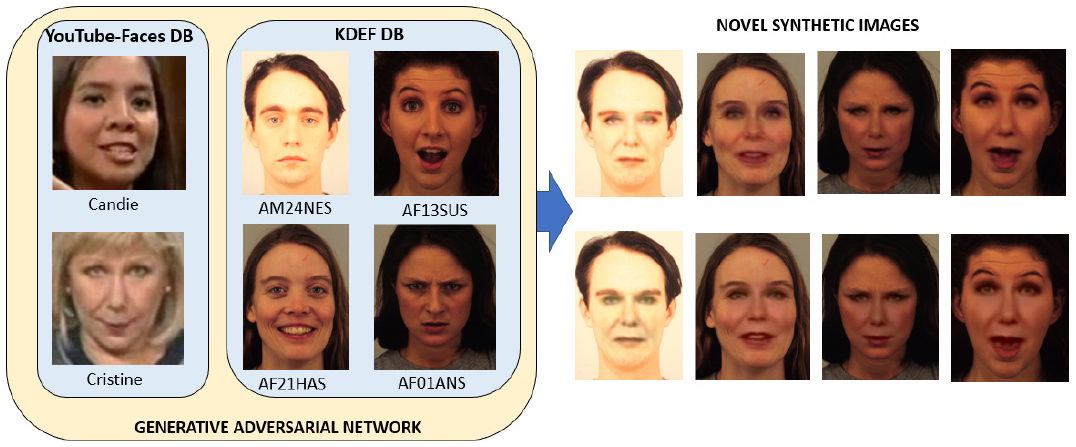
Figure 2. Examples of novel synthetic images generated with the GAN.